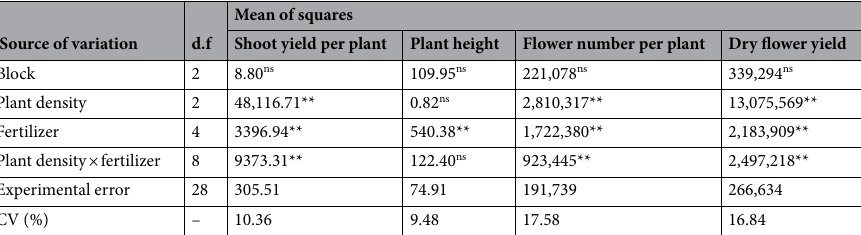
Table 3. Analysis of variance (mean of squares) of some growth characteristics and yield of Echium amoenum affected by different types of fertilizers and plant densities. **, * and ns are significant at the 0.01 and 0.05 of probability level and non-significant,